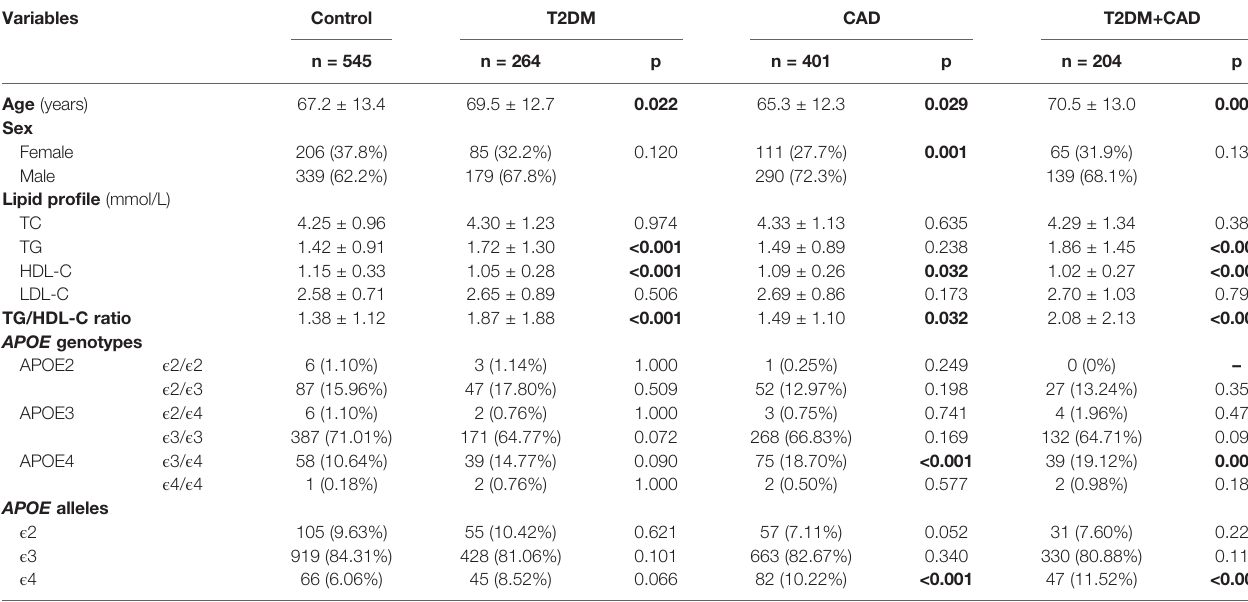
TABLE 1 | Clinical characteristics and genotype distribution of APOE gene in different groups. Variables